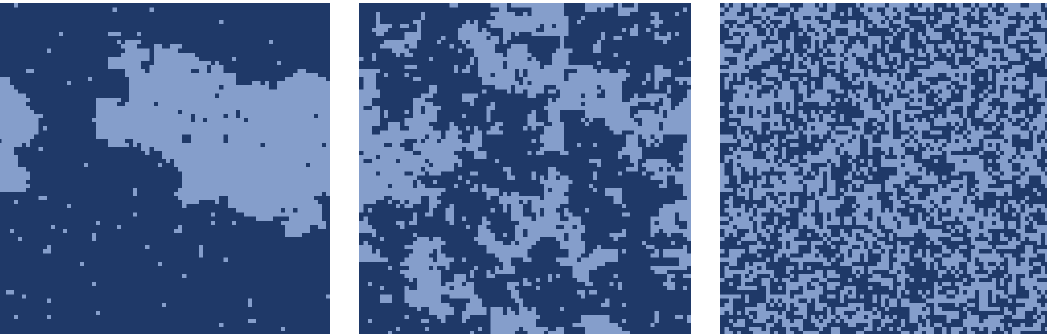
Figure 2. Typical patterns of the Ising model: ( Left ) T < T c ; ( Middle ) T = T c , notice the appearance of a percolating cluster; and ( Right ) T > T c